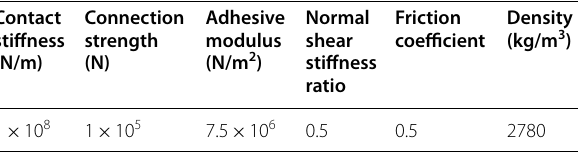
Table 4 Elastic and mass properties of particle materials in the discrete element